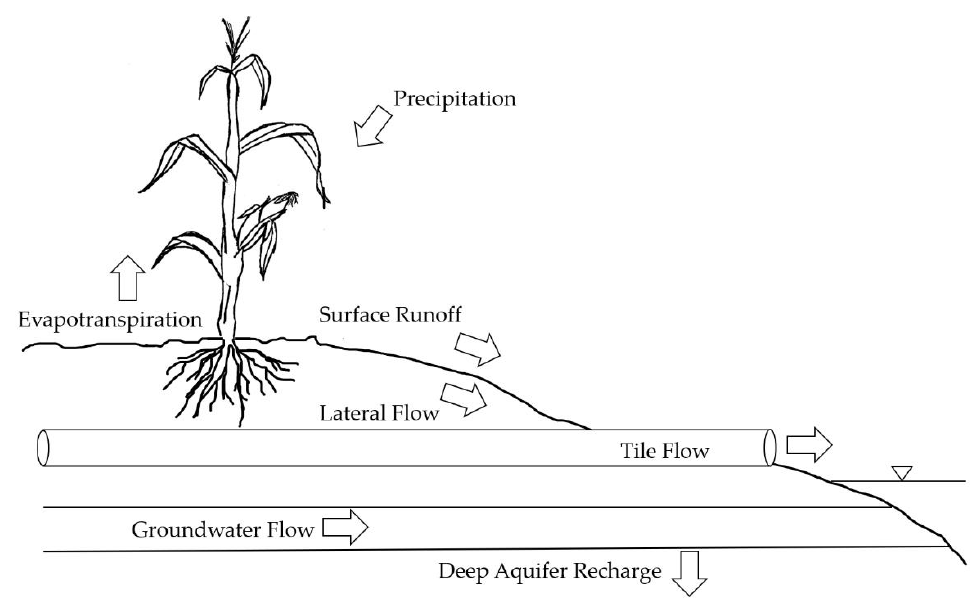
Figure 3. Hydrological system for the Matson Ditch Watershed.